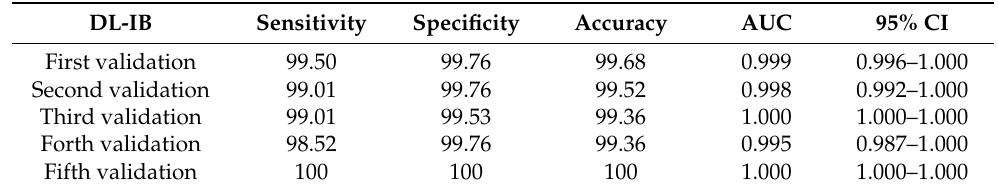
Table 3. Results summary of five-fold, cross-validation of DL-IB model for detecting incomplete scan coverage at the lung bases (CI, confidence interval).